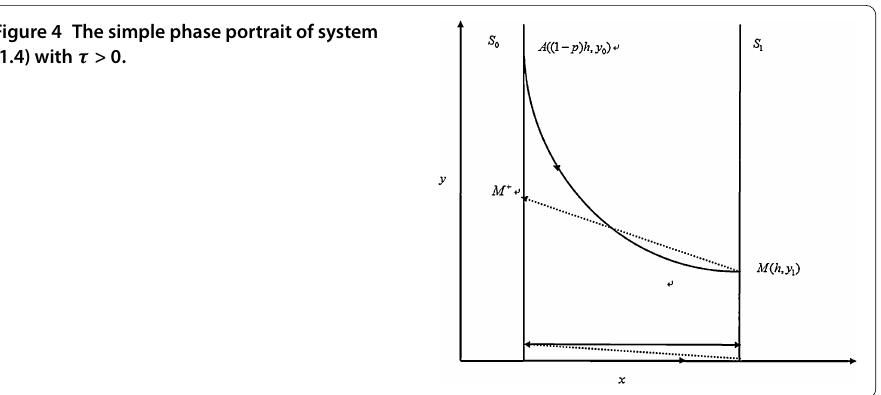
Figure 4 The simple phase portrait of system (1.4) with τ >